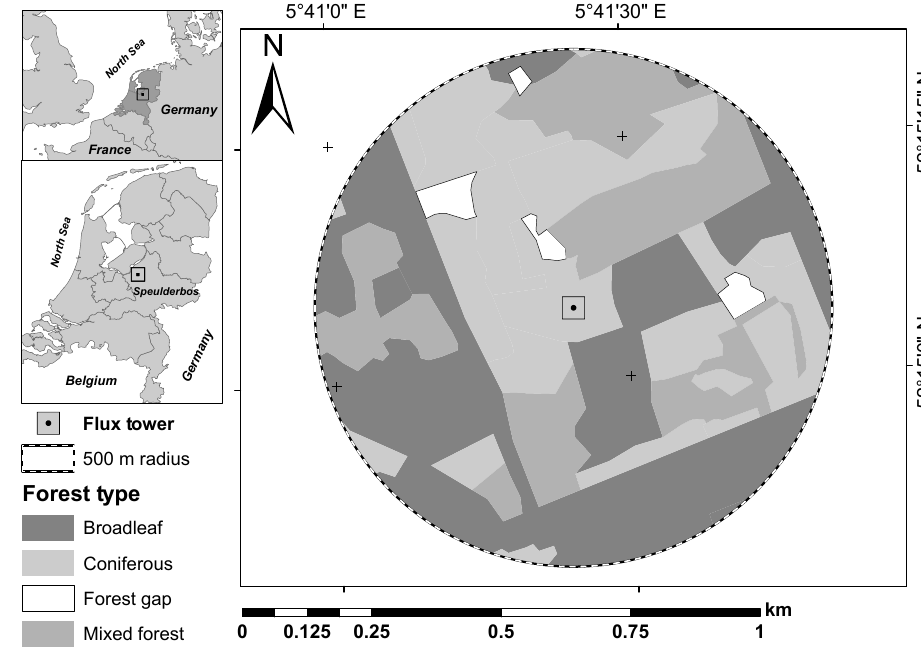
Figure 1. Forest type distribution within 500m of the tower site at Speulderbos Forest, the